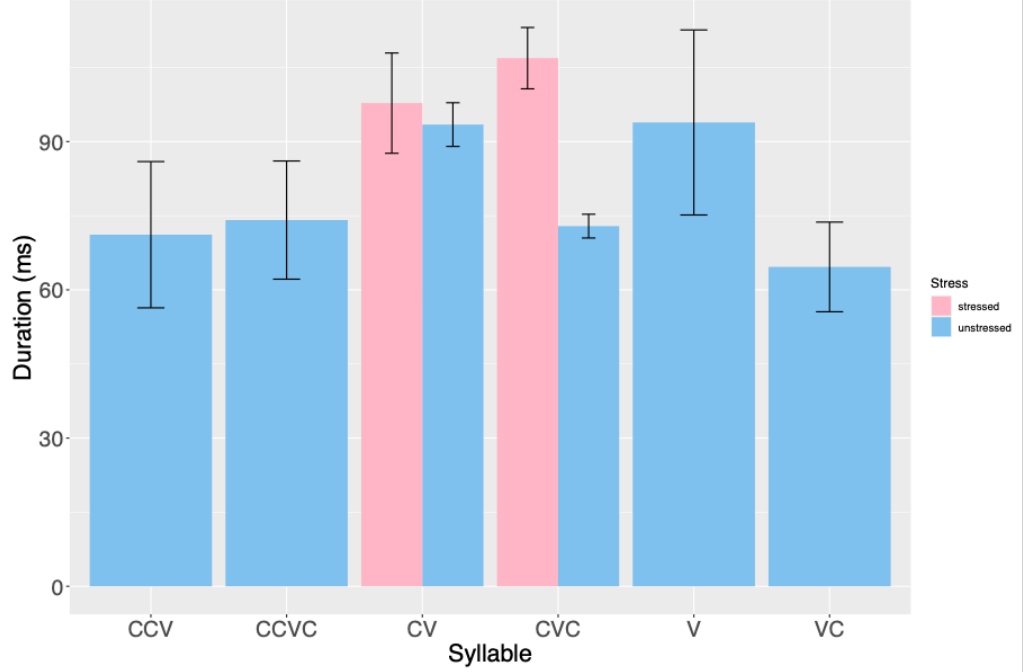
Figure 6. Mean duration (milliseconds) for vowels in stressed and unstressed contexts in CCV, CCVC, CV, CVC, V and VC